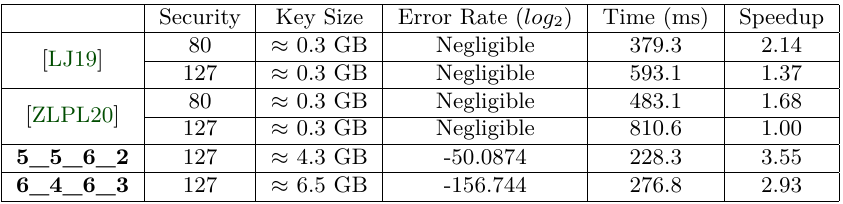
Table 7: Comparison between implementations of an 8-bit max function.